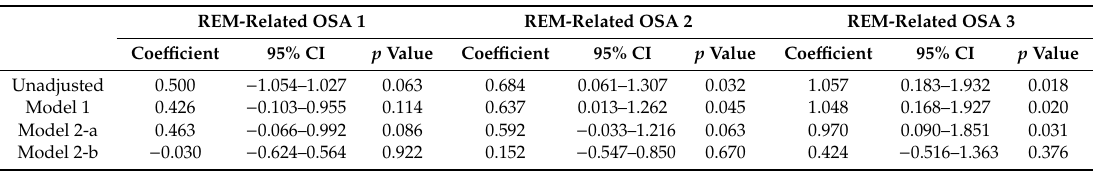
Table 3. Association between three di ff erent definitions of REM-related OS) and the Pittsburgh Sleep Quality Index score in male patients.